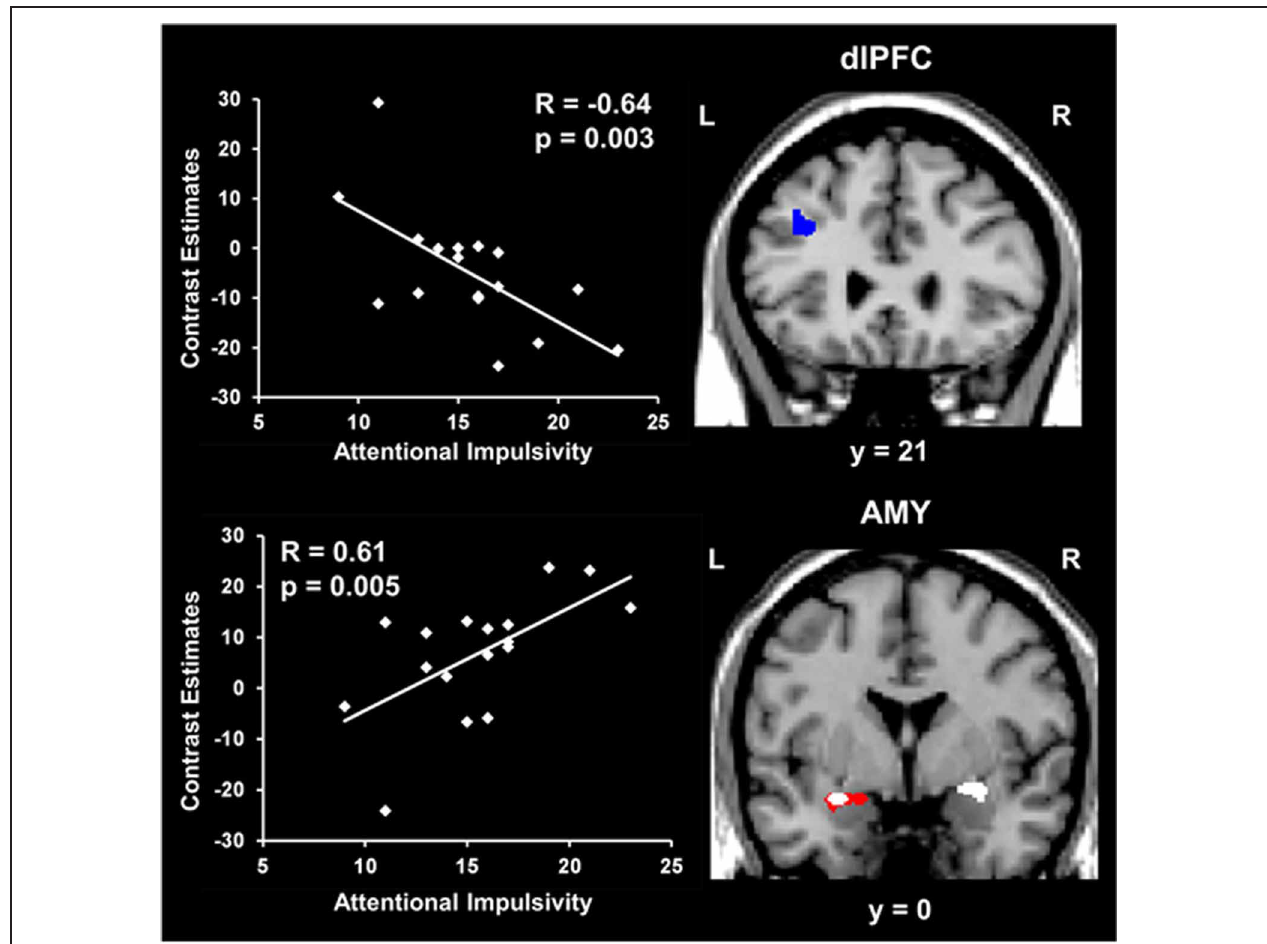
FIGURE 6 | Opposing co-variation of activity in HotEmo (AMY) and ColdEx (dlPFC) regions with individual differences in Attentional Impulsiveness. Bilateral AMY activity increased (white clusters) and left dlPFC activity (BA 8/9) decreased (blue cluster) with individual scores of attentional impulsivity (AI). Interestingly, the positive correlation and the difference in activity overlapped in a left AMY area also showing increased activation in subjects showing impaired WM performance to emotional distraction (red cluster). Also, the positive co-variation identified at the